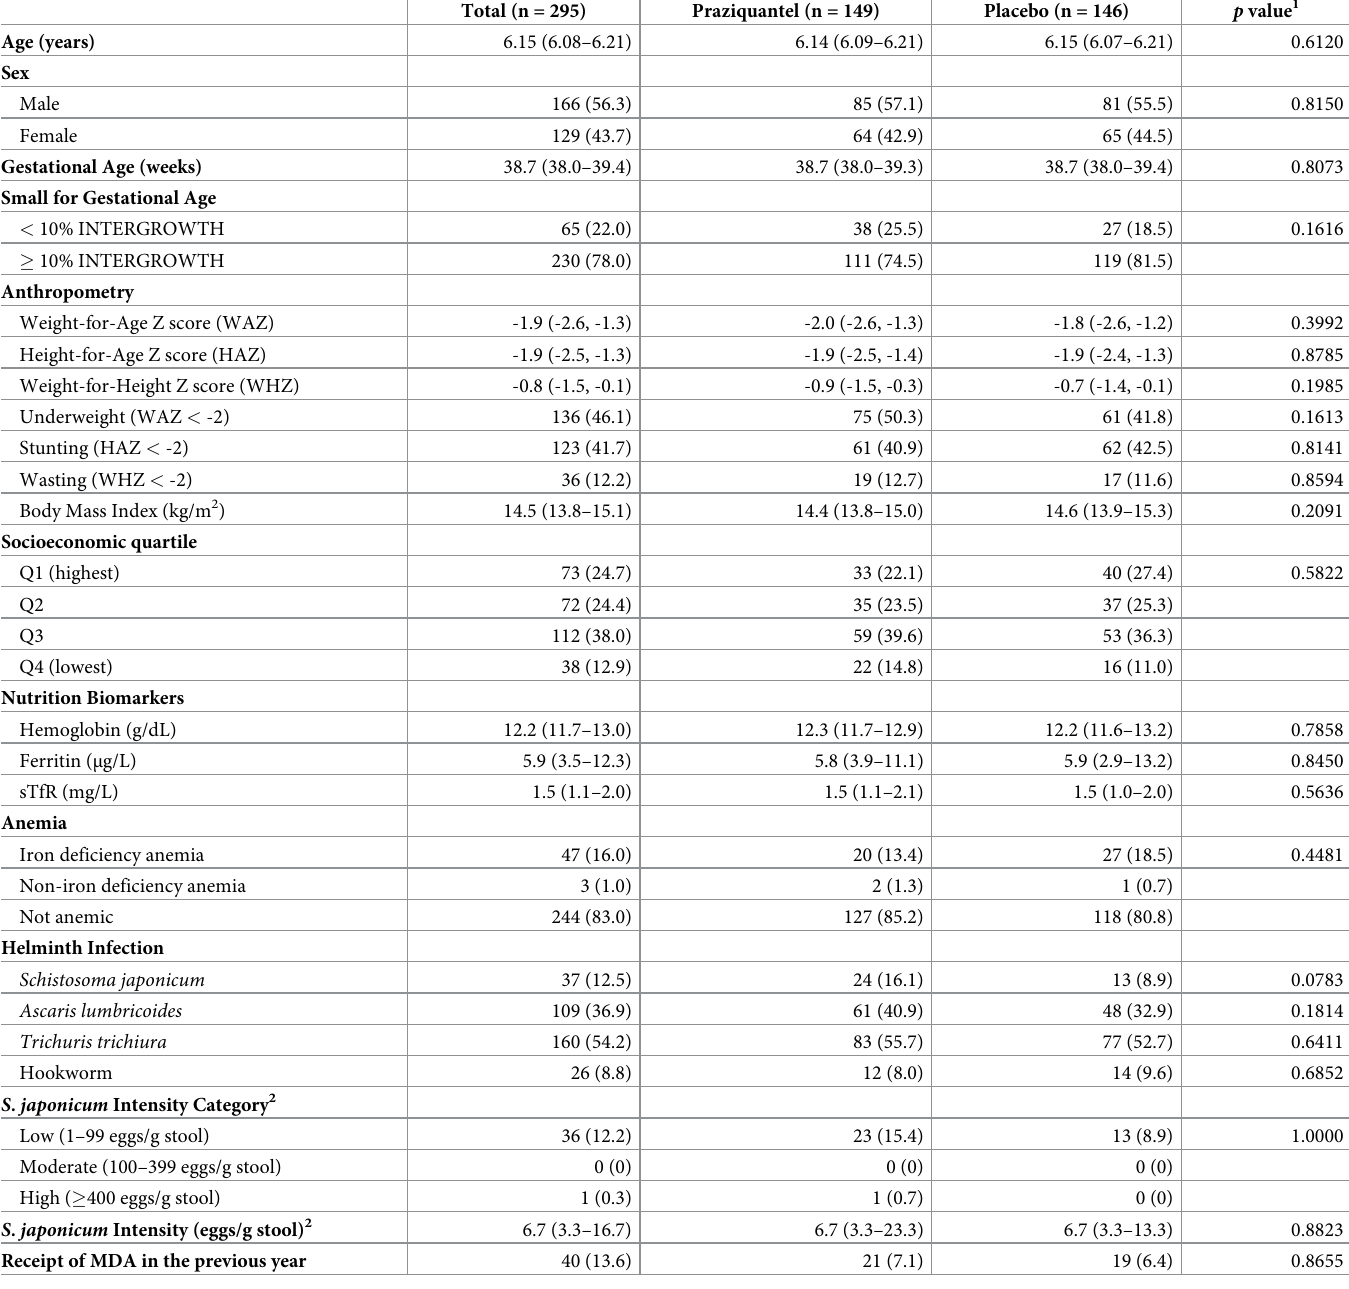
Table 1. Participant characteristics by maternal treatment